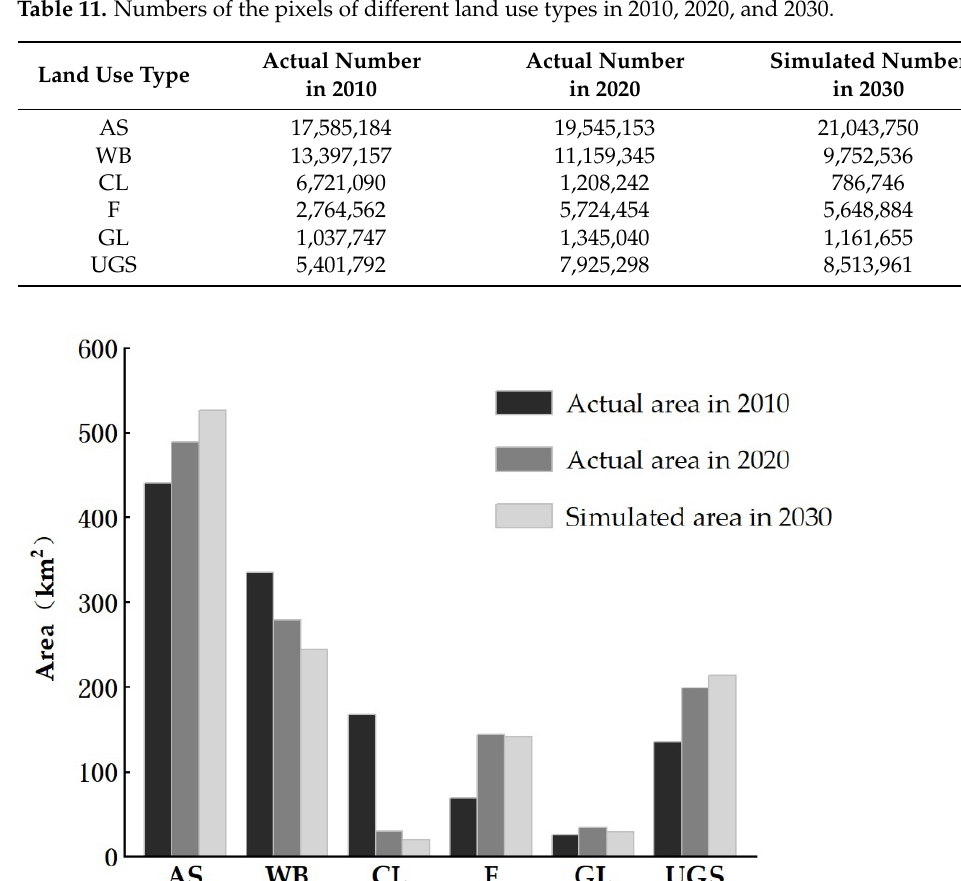
Figure 5. Area change of different land use types in Wuhan urban areas from 2010 to